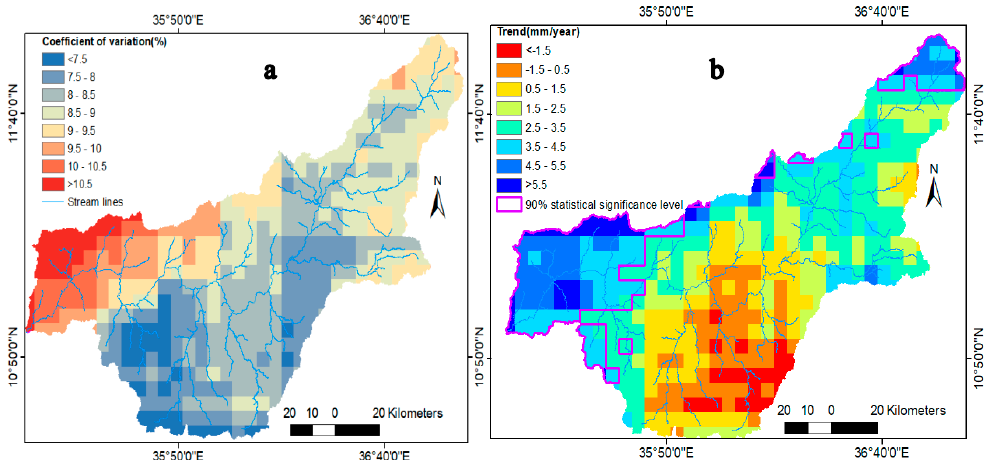
Figure 11. Spatial and temporal c haracteristics of rainfall during the period 1981–2017: ( a ) coefficient of variation, ( b ) trend (rate of change measured as the slope of linear trend in mm year − 1 ), pink colored lines represent the 90% statistical significance level.